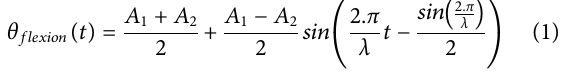
Frontiers in Robotics and AI |